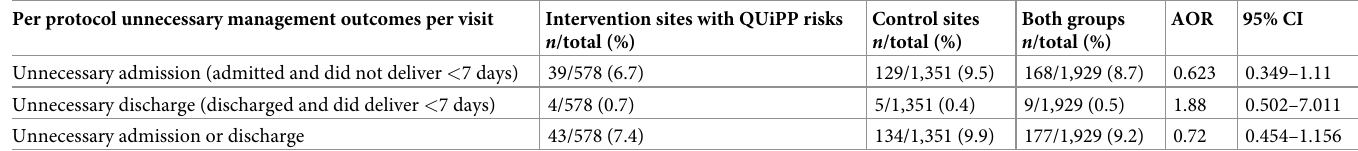
Table 4. Unnecessary admissions and discharges if 5% threshold was adhered to at intervention sites using QUiPP app versus control sites using conventional management. Per protocol unnecessary management outcomes per visit